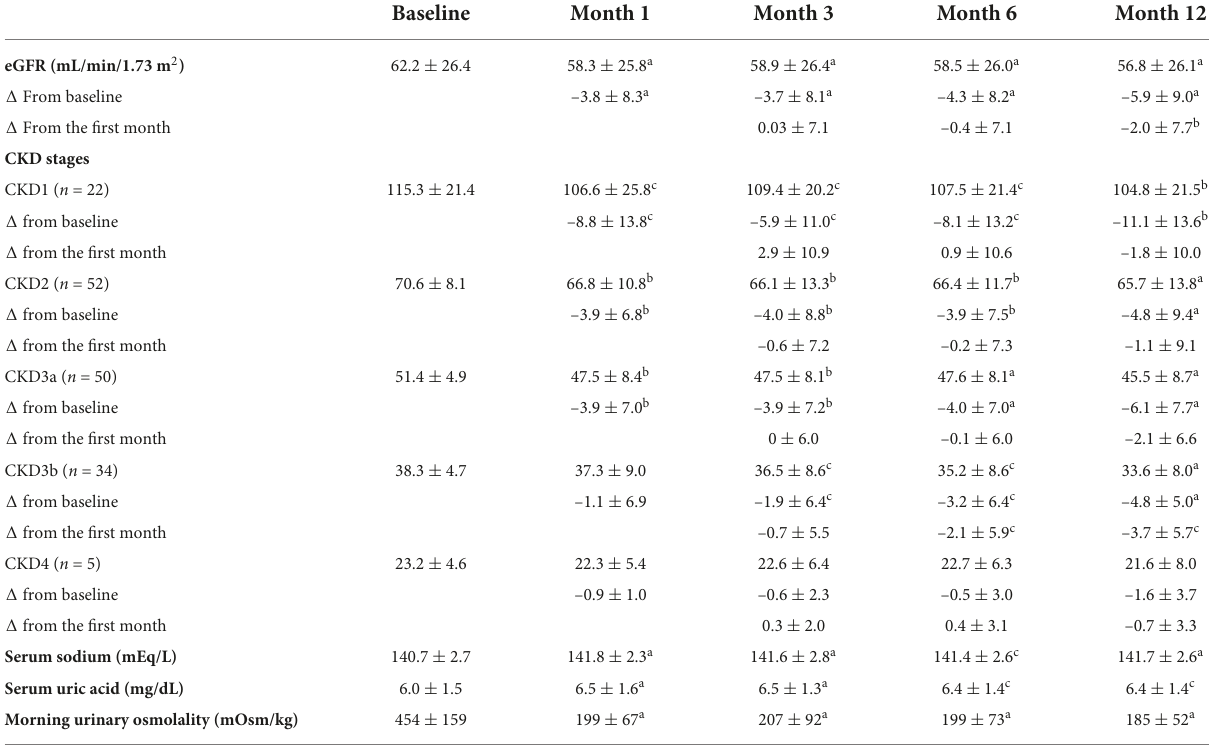
TABLE 2 Evolution of eGFR, globally and by subgroups of CKD, and for serum sodium, uric acid, and morning urinary osmolality during the first year of treatment with tolvaptan.